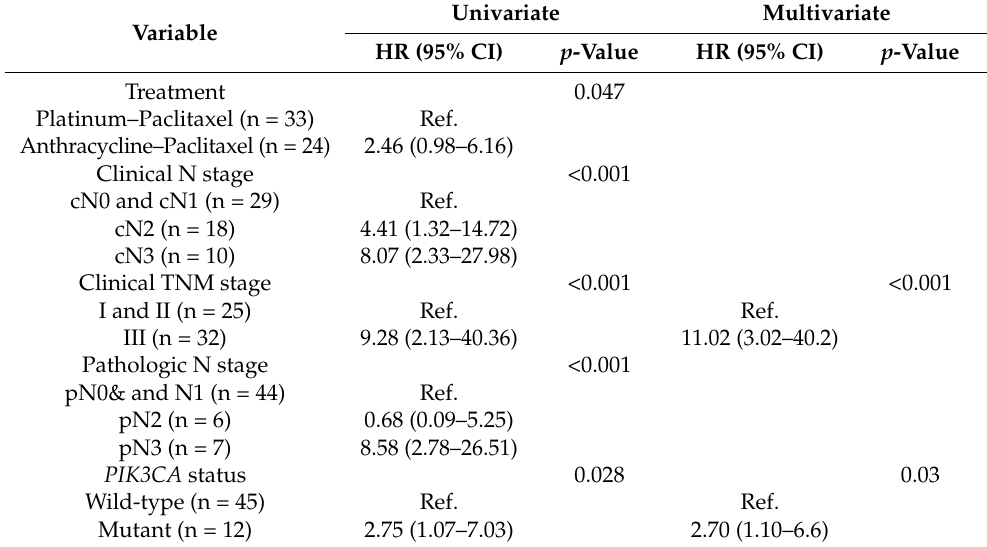
Table 2. Univariate and multivariate survival analysis of 57 non-pathologic complete response triple-negative breast cancer